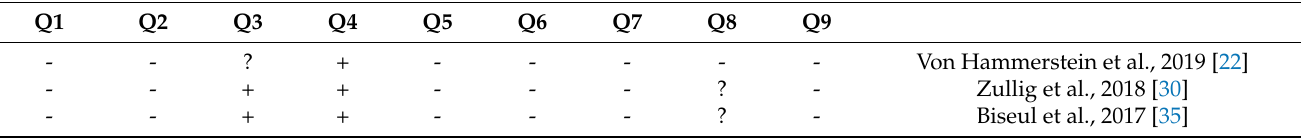
Table A5. Evaluation of methodological quality of included quasi-experimental